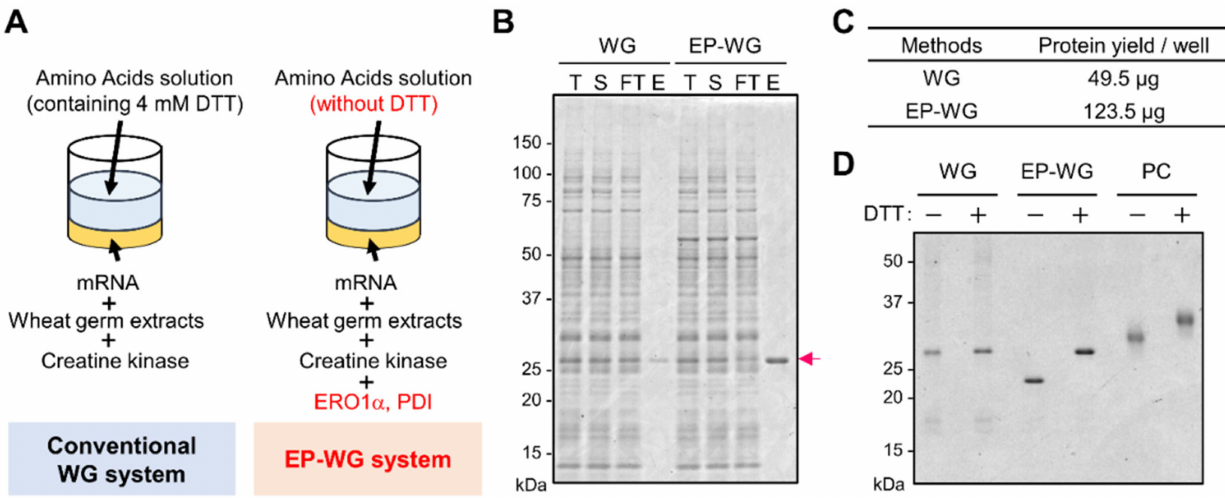
Figure 1. Production of SARS-CoV-2 RBD containing disulfide bonds using the wheat germ cell- free protein synthesis system. ( A ) Schematic diagram of the different wheat germ (WG) cell-free protein synthesis methods. DTT-free amino acid substrate solution and WG containing ERO1 α and PDI (EP-WG) was used for the synthesis of disulfide-bond-intact protein. ( B ) Purification of RBD using nickel-chelated sepharose beads. Each protein fraction was analyzed by SDS-PAGE and visualized by CBB staining. Arrow indicates the RBD. T, Total; S, Supernatant; FT, Flow Through; E, Elution. ( C ) Comparison of protein yield synthesized by two methods. Protein yield was normalized by expression scale (1 well of 6-multi-well plate). Protein concentrations of purified protein were quantified by bicinchoninic acid (BCA) assay. ( D ) Confirmation of disulfide bond formation of RBD using non-reducing SDS-PAGE analysis. Each protein was incubated with or without 100 mM of DTT for 30 min at 37 ◦ C prior to SDS-PAGE analysis. Commercially available RBD protein produced by mammalian cell expression system was used as positive control